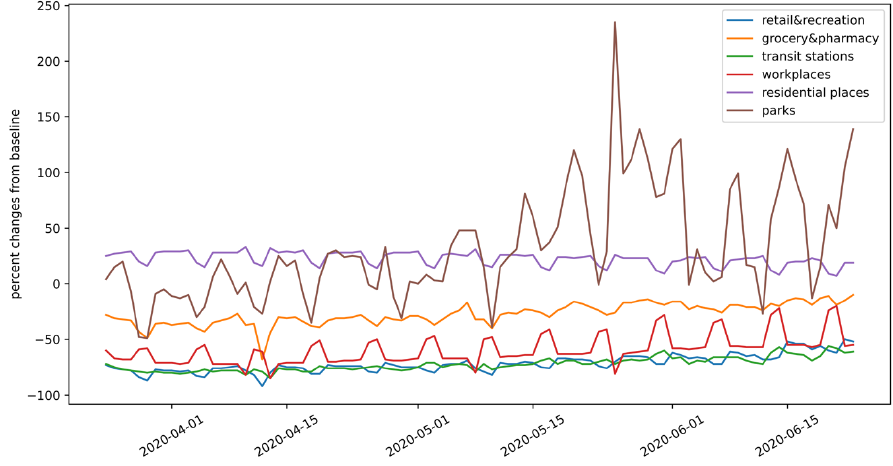
Figure 3. The mobility trends during the first lockdown in Leeds.